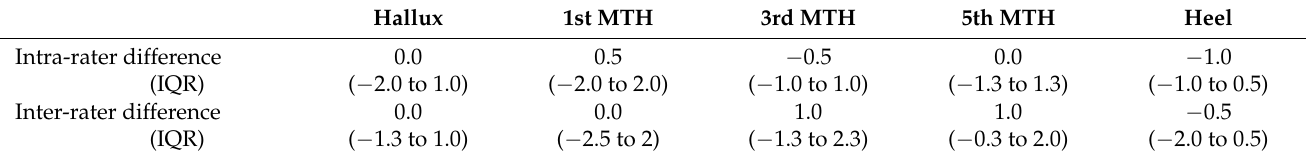
Table 3. Intra- and inter-rater differences of the smallest perceivable grades (SPGs) and their in- terquartile ranges (IQRs). Negative values indicate that the SPG in the first test was smaller in the intra-rater investigation and SPG of one examiner was smaller in the inter-rater investigation.